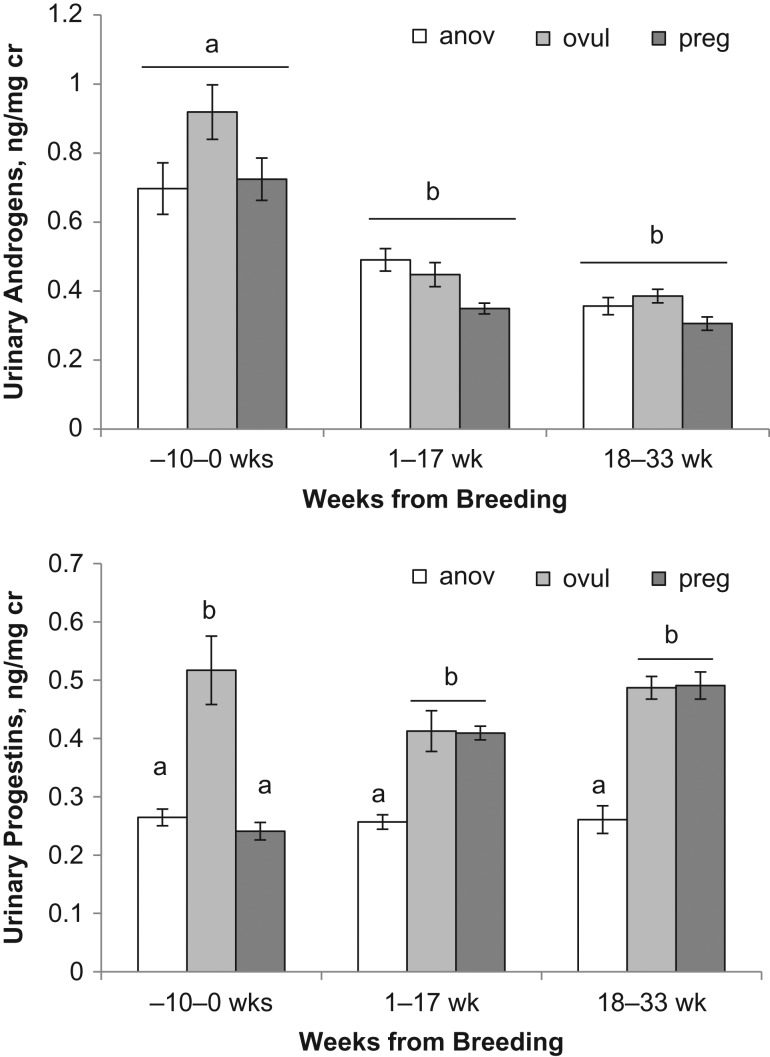
Urinary progestin and androgen concentrations (mean ± SEM) of captive female polar bears during the presumed period of embryonic diapause (1–17 weeks) and the secondary surge in progestins (18–33 weeks) for pregnant cycles (n = 3) in comparison to the same time interval for ovulatory-non-parturient (n = 4) and anovulatory (n = 4) cycles. Different letters indicate significant differences between reproductive categories and time interval.